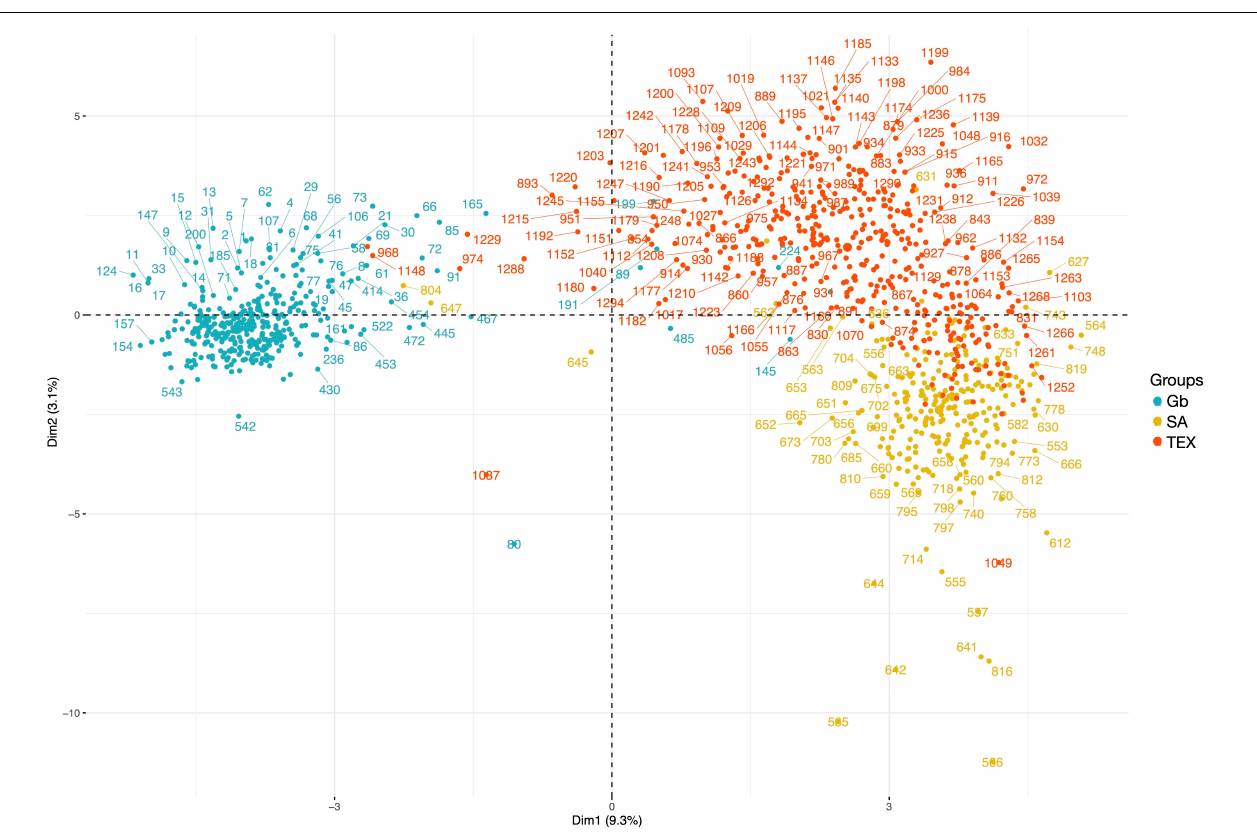
FIGURE 8 | Multiple correspondence analysis cloud of individuals across groups. The graph shows similarities of the individuals in terms of all categorial descriptor variables. The first two principal components are shown (DIM 1 + DIM 2: 12.4%). Accessions are colored by group for Gb (blue), SA (yellow), and TEX (red); accession index numbers can be found in Supplementary Tables 2–4 .